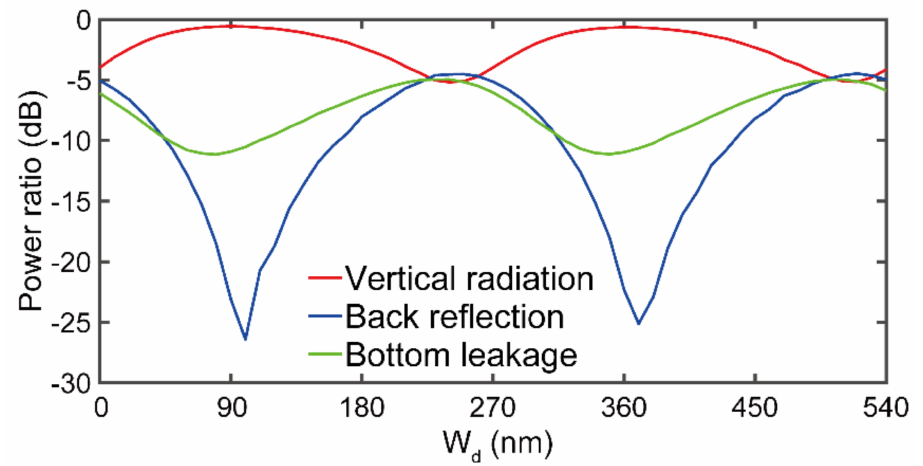
Figure 3. Vertical radiation (red), back reflection (blue) and bottom leakage (green) as a function of the connecting waveguide